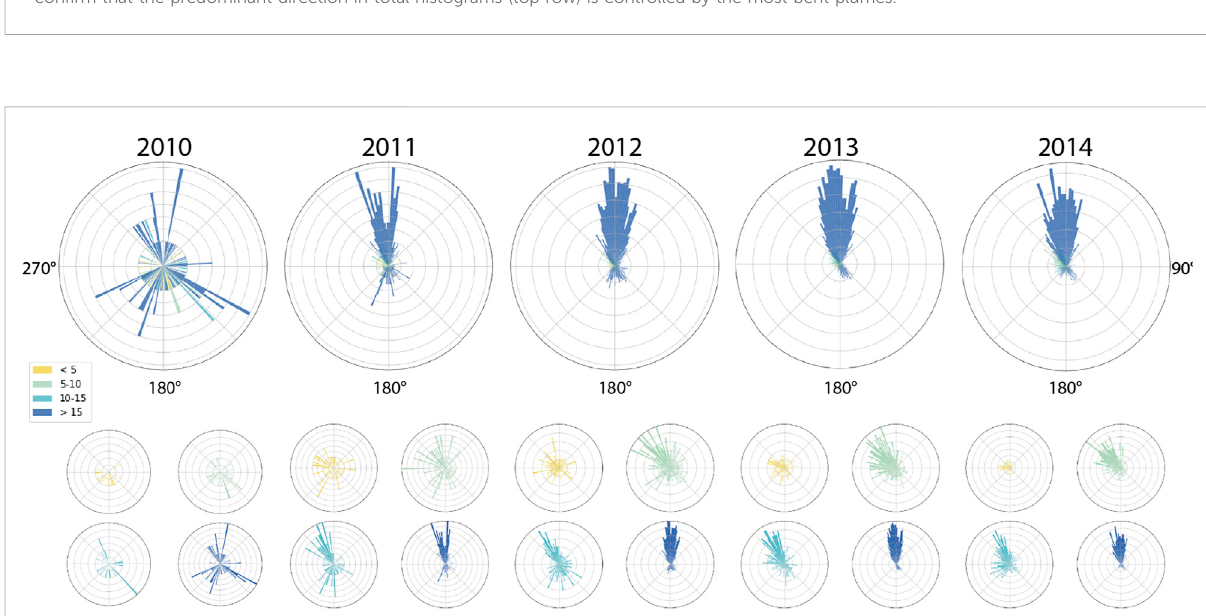
FIGURE 4 Comparison ofplumebending azimuthforthefullrecord(1monthin2010,3monthsin2011,12monthsfortherest)ineachyear.Azimuthsare binned separately for inclination ranges of < 5 ° (yellow), 5 – 10 ° (green), 10 – 15 ° (aqua), and > 15 ° (blue). Separate plots for each range (middle row) con fi rm that the predominant direction in total histograms (top row) is controlled by the most bent plumes.